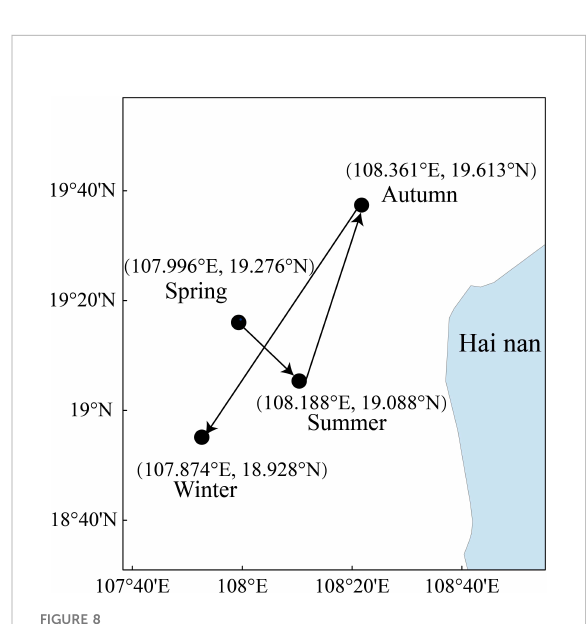
FIGURE 8 The current core seasonal distributions of Trichiurus japonicus in the Beibu Gulf, South China